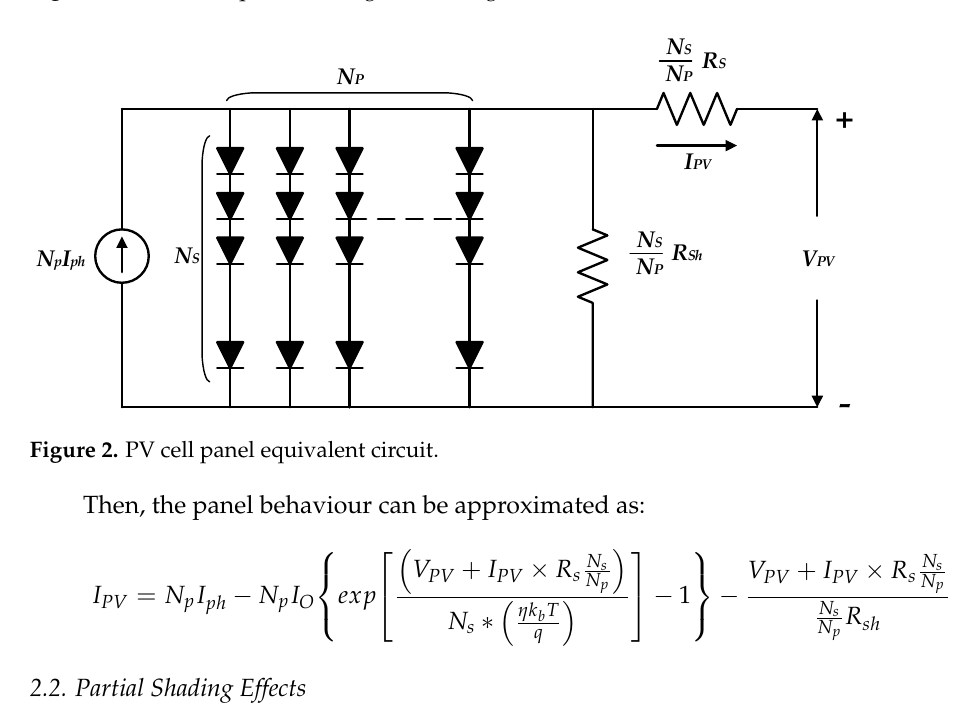
- Figure 2. PV cell panel equivalent circuit. Then, the panel behaviour can be approximated as: